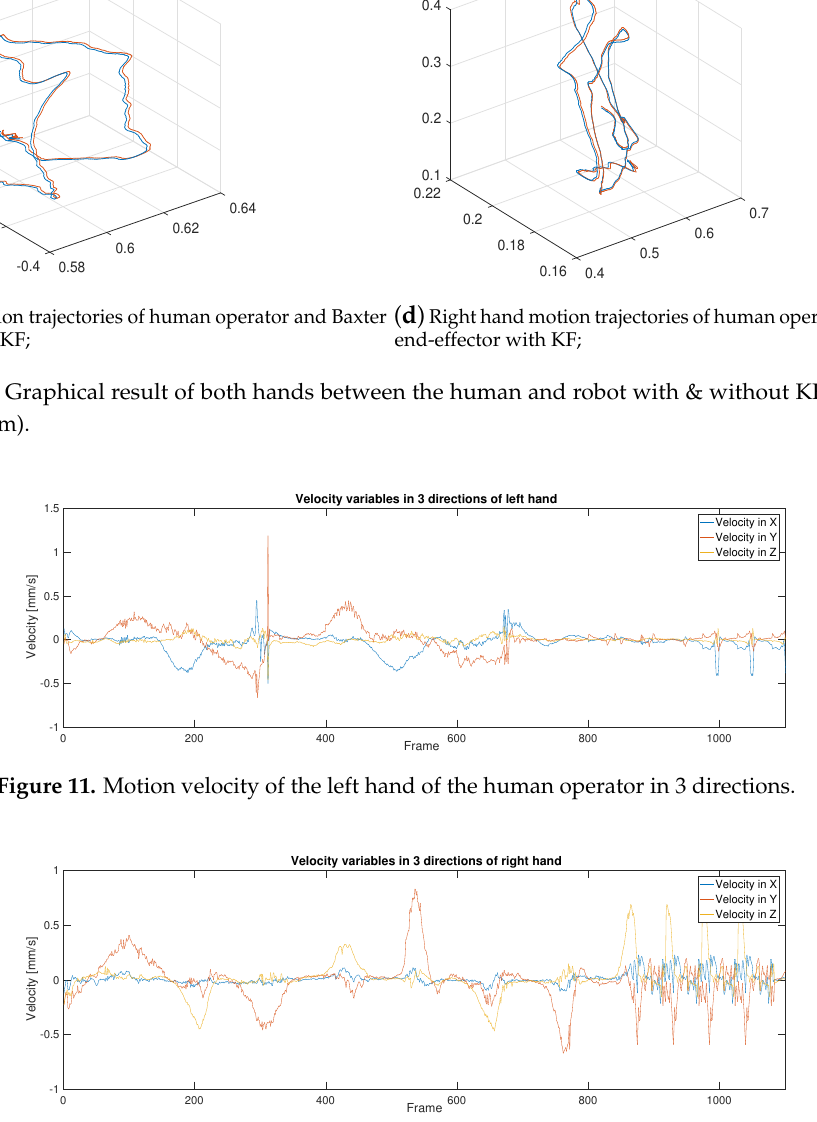
( b ) Right hand motion trajectories of human operator and Baxter end-effector without KF; Generated trajectories of right hand and right Baxter EE with KF